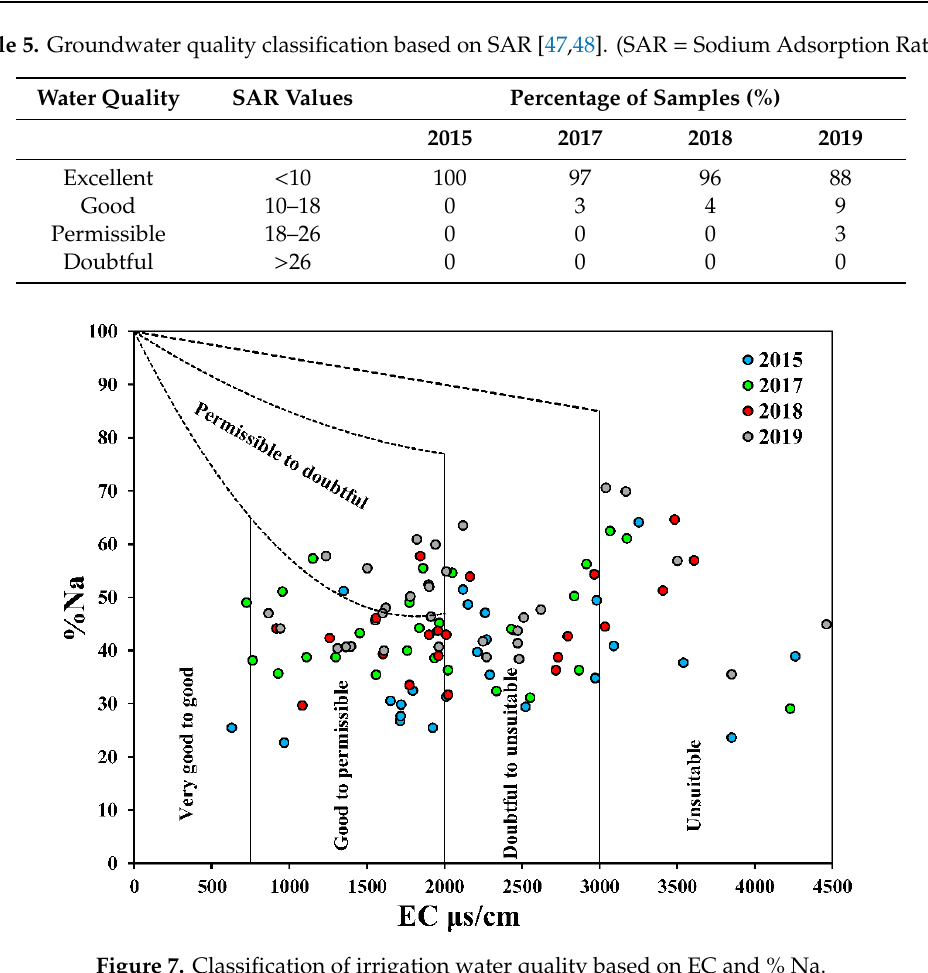
Figure 8. Classification of irrigation water quality based on EC and SAR.